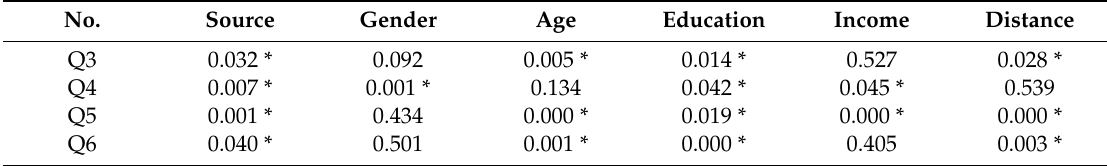
Table 5. The significance level of PAW towards WTE.